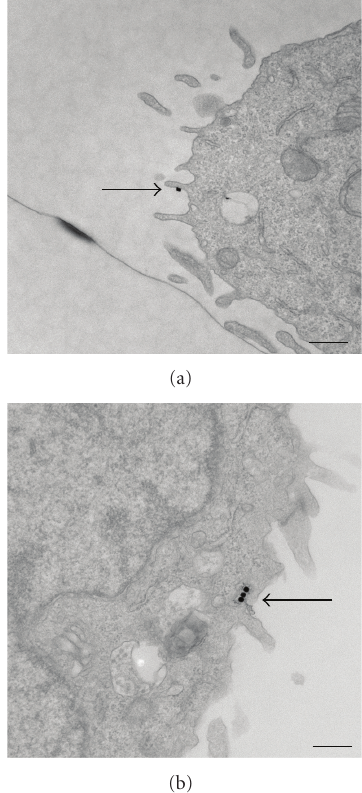
Figure 2: Transmission electron microscopy images of RBL-2H3 cells (a) 5min after incubation of nanosensors and (b) 60 min after incubation with nanosensors. Arrows are added to pinpoint locations of nanosensors within the cells. Bars = 500 nm. Reprinted with permission from Nowak-Lovato et al. [11] (copyright 2010